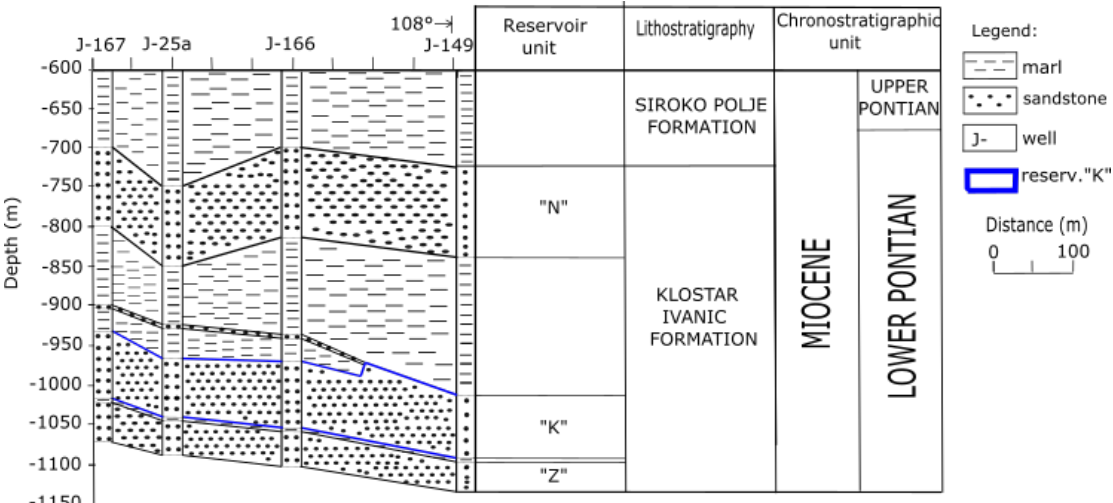
Figure 3. Correlation section through wells J-167 – J-25alfa – J-166 – J-149 shown on Figure 2 with reservoir boundaries marked by blue line (from [18]).